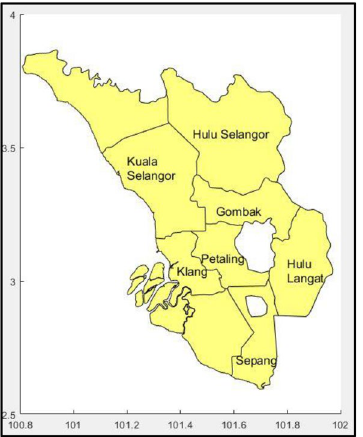
Figure 1. Locations of study districts in Selangor,